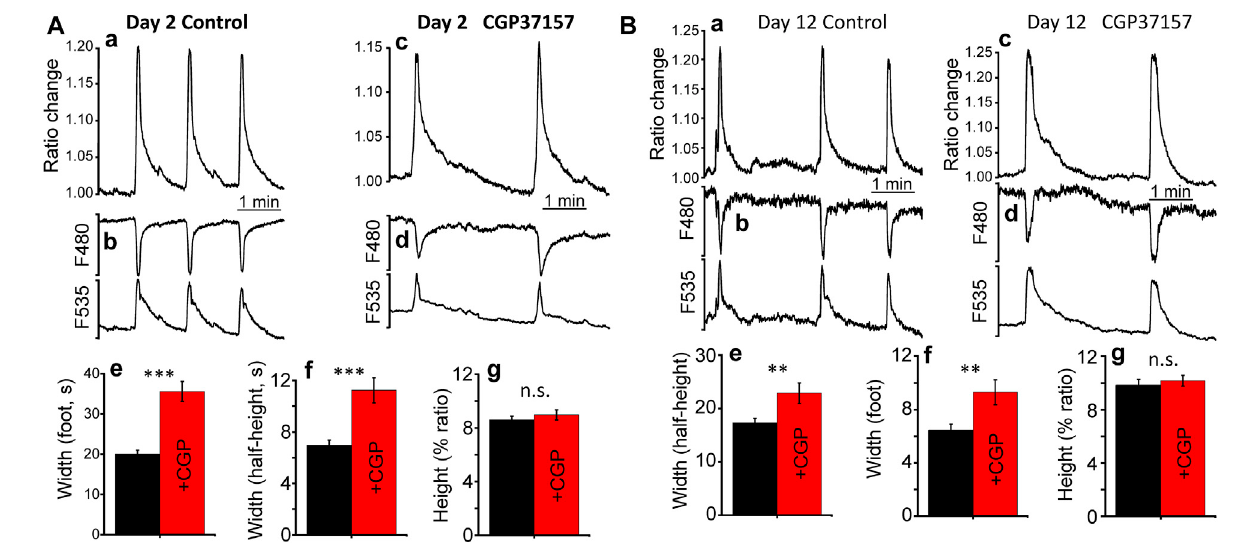
FIGURE 7 | Effect of CGP37157 on C. elegans vulva cytosolic [Ca 2+ ] at day 2 (A) and day 12 (B) of adult life. Panels a and c show 5 min of typical records of spontaneouscytosolic[Ca 2+ ]oscillationsobtainedfrom C.elegans wormsatday2ofadultlifeeithertreated(panelc)oruntreated(panela)with50 µMCGP37157since day 1 of adult life. Panels b and d show the single wavelength records with emission at 480 and 535 nm corresponding to the 5 min ratio records of the panels above, showingtheexpectedmirrorchanges.Panelse.g.,andhshowthemeanpeakwidthatthefootofthepeak,themeanpeakwidthathalf-heightandthemeanpeak height of the vulva cytosolic [Ca 2+ ] oscillations. *** p < 0.001; ** p < 0.01; ANOVA test, n (cid:2) 113 to 190 peaks analyzed.